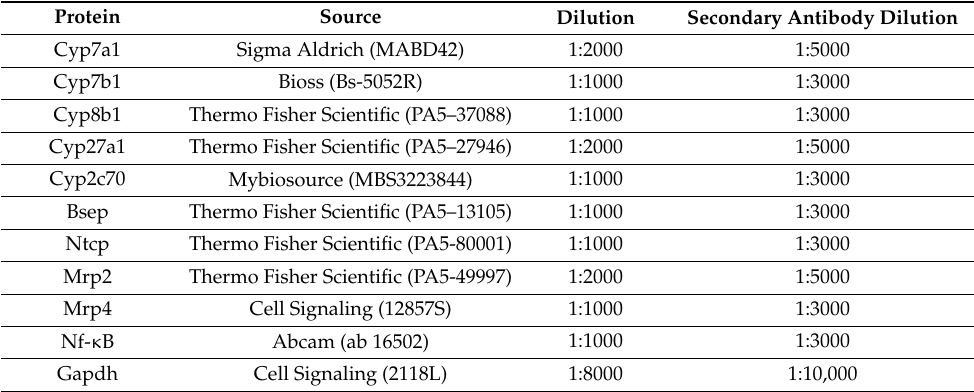
Table 2. Primary and secondary antibodies used in Western